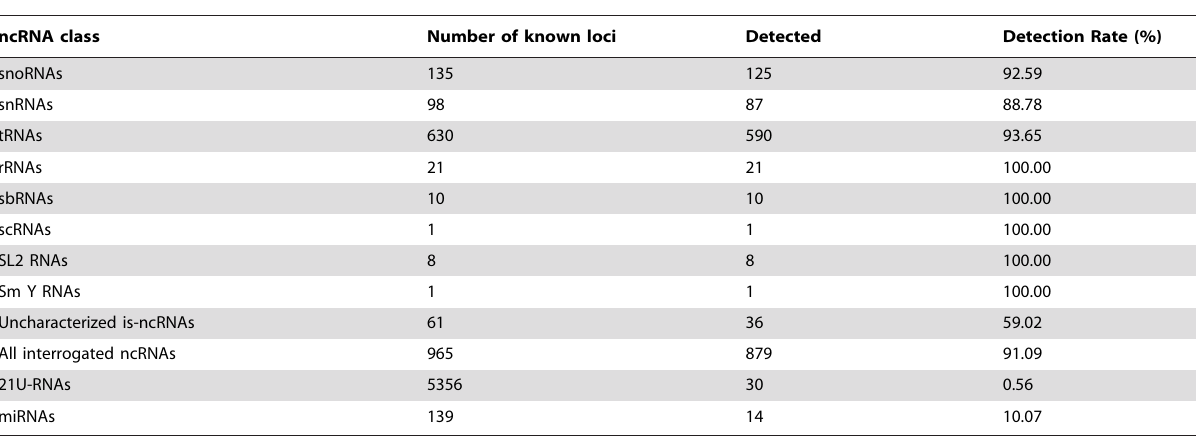
Table 1. Detection rate of known ncRNA loci.